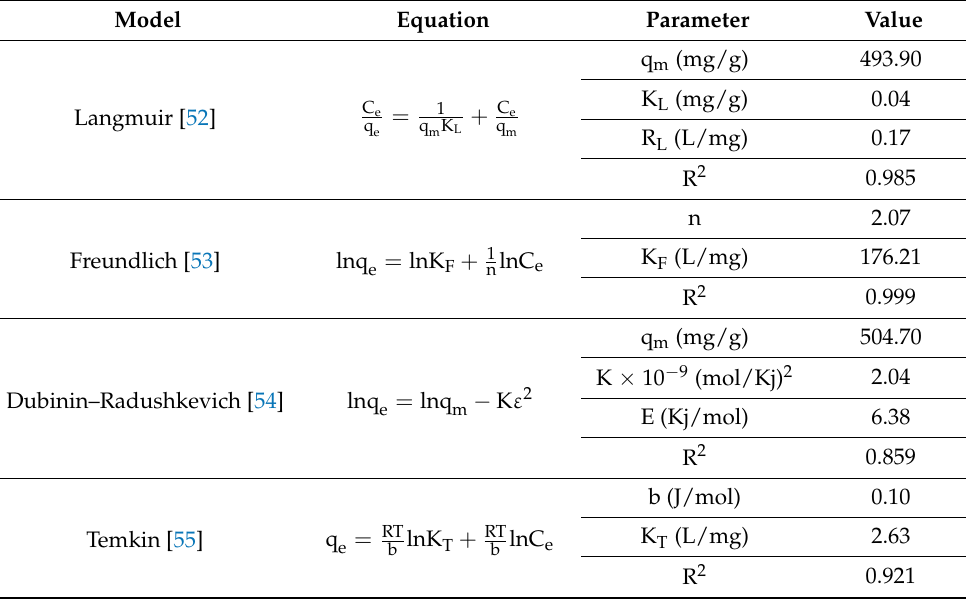
Table 2. Different isotherm constants for the adsorption of BF dyes onto MgO